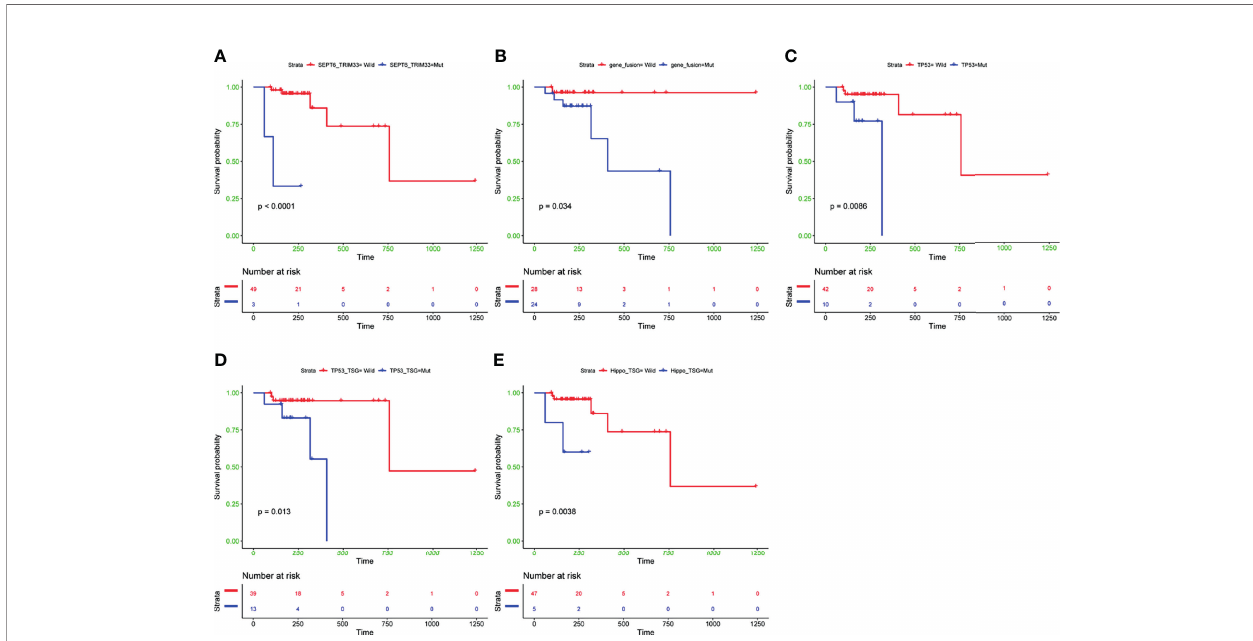
FIGURE 4 | Kaplan-Meier curves of PFS differences between subgroups with and without SEPT6 _ TRIM33 gene fusion (A) , any of fi ve fusion genes detected in at least of two cases (B) , TP53 gene mutation (C) , mutated TP53 pathway (D) , mutated Hippo pathway (E) . PFS, progression-free survival. P values were calculated by the log-rank